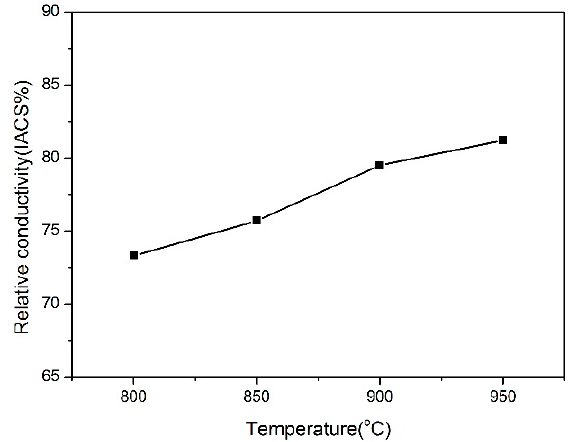
Figure 7. Conductivities of Cu–V composites sintered at different temperatures.